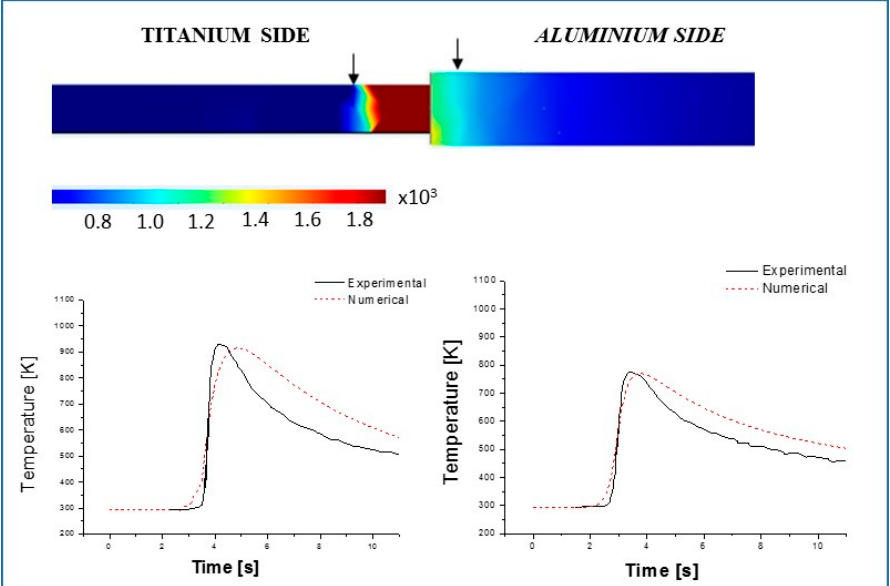
Figure 15. Experimental and numerical thermal cycle using 2D heat source modelling.